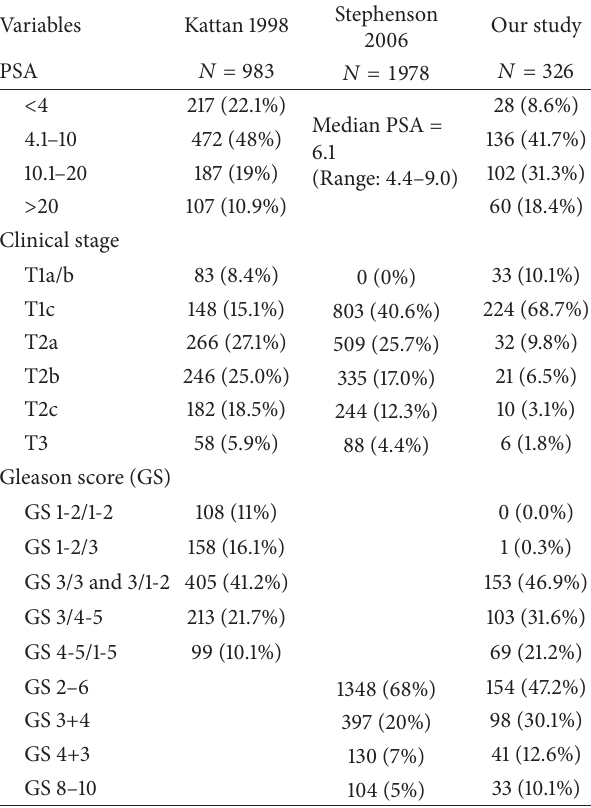
Table 1: Background demographics of patients with prostate cancer undergoing prostatectomy.